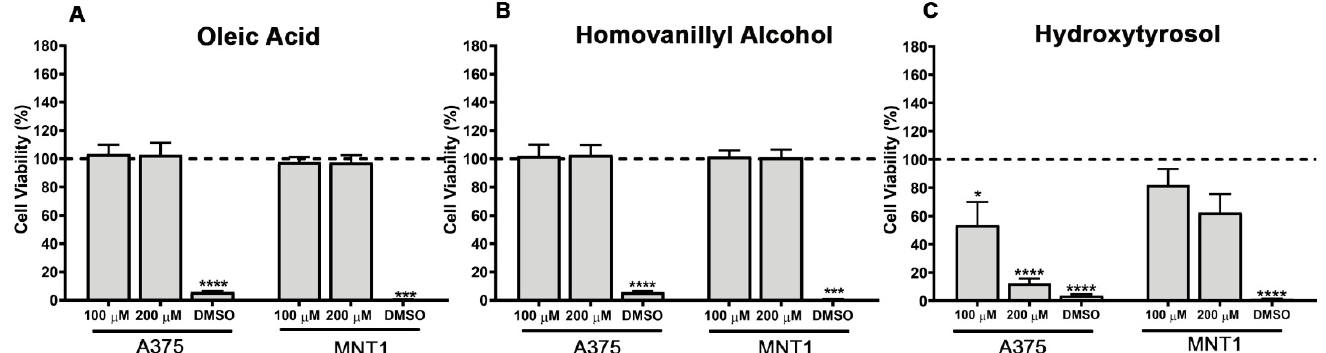
Figure 1. Effects of ( A ) oleic acid, ( B ) homovanillyl alcohol, and ( C ) hydroxytyrosol treatment at concentrations of 100 µ M and 200 µ M on the metabolic viability of A375 and MNT1 cells, 48 h post incubation. Cell viability of untreated control cells is represented by the dashed line at 100%. Cells treated with 5% dimethyl sulfoxide (DMSO) were used as a positive control of cell viability. Results are representative of at least three independent experiments, performed in triplicate. Data obtained are shown as mean ± standard error of the mean (SEM). Student’s t -test was used to compare each experimental condition with the respective untreated control, * p < 0.05, *** p < 0.001, **** p < 0.0001.